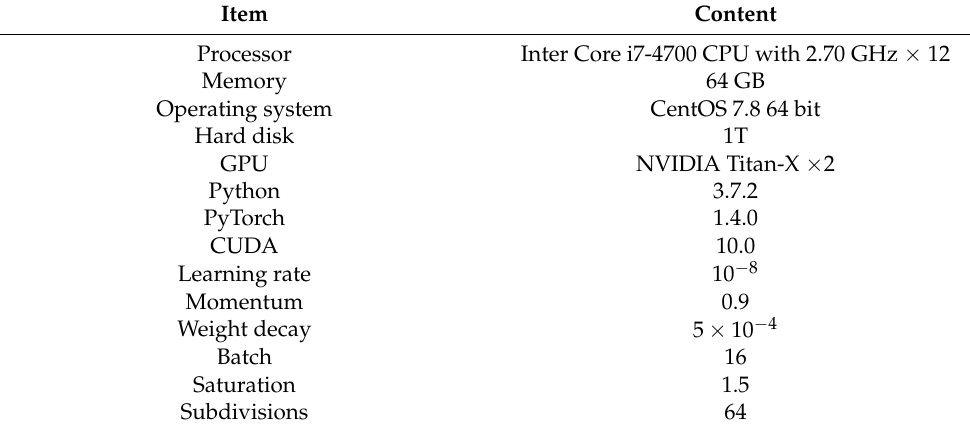
Table 1. Experimental environment